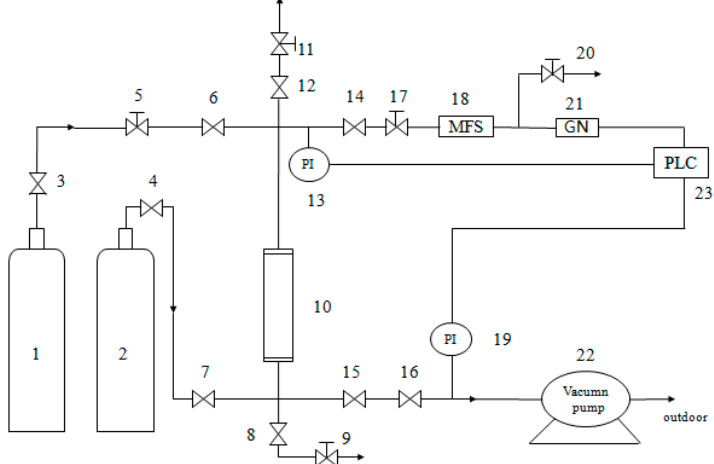
Figure 2. The dynamic test device. 1: He cylinder; 2: Mixture cylinder of CH 4 /N 2 ; 3 and 4: Pressure reducing valve; 5, 9, 11, 17 and 20: Needle-type valve; 6, 7, 8, 12, 14, 15 and 16: Common valve; 10: Absorbing tower (16 mm × 320 mm); 13 and 19: Pressure probe; 18: Mass flow controller; 21: Gas analyzer; 22: Vacuum pump; 23: Windows control center (Copyright © 1994–1997 SIEMENS, Germany).